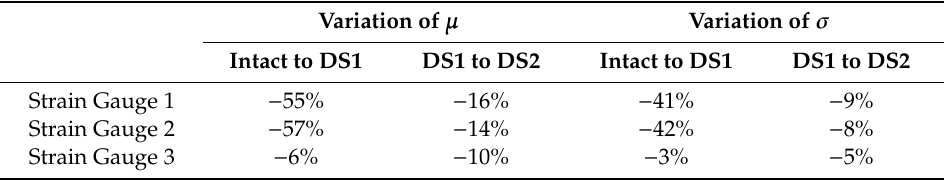
Table 2. Damage localization using the variation of µ and σ